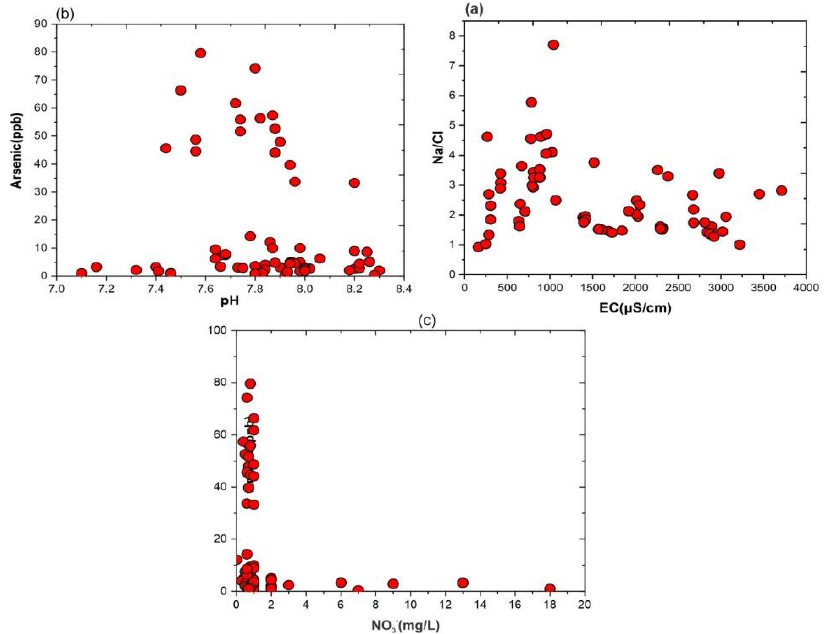
Figure 3. Scatter plot, Na/Cl vs. EC ( a ), scatter plot of As vs. PH ( b ), and NO 3 − vs. As plot ( c ).